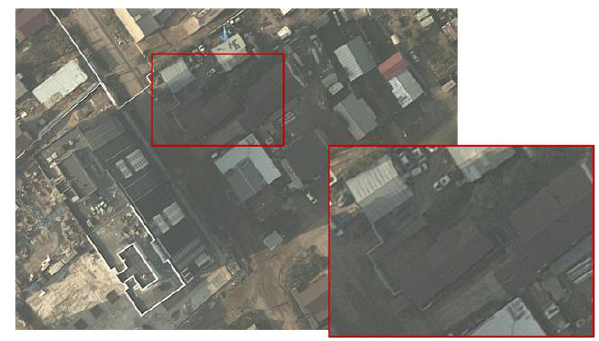
Figure 5. An example of atmospheric haze influence on interpretation quality of an aerial image To avoid the haze appearance on images the aerial surveying should be performed when the haze is not visually perceived and the horizontal meteorological visibility range is not less than 10 km. 3 Methods of haze assessment: visually as general bright background in image and the